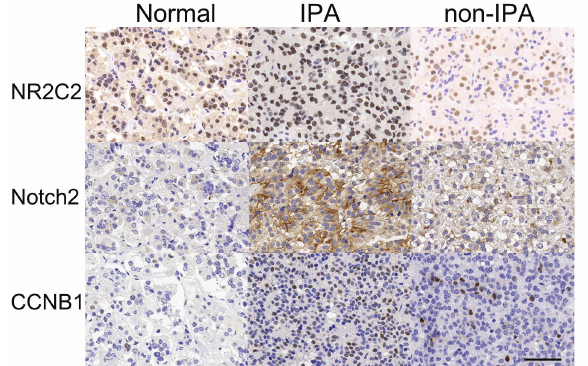
Figure 1: IHC analysis of the NR2C2, Notch2 and CCNB1 in prolactinomas NR2C2 and CCNB1: nuclear staining; Notch2: cytoplasmic staining.